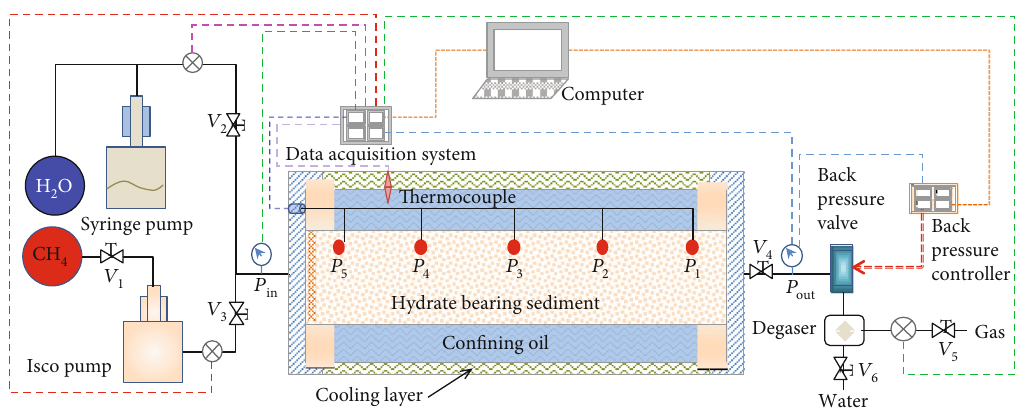
Figure 1: Schematic diagram of the hydrate production simulation